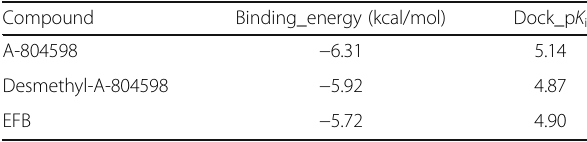
Table 2 Post-docking affinity analysis